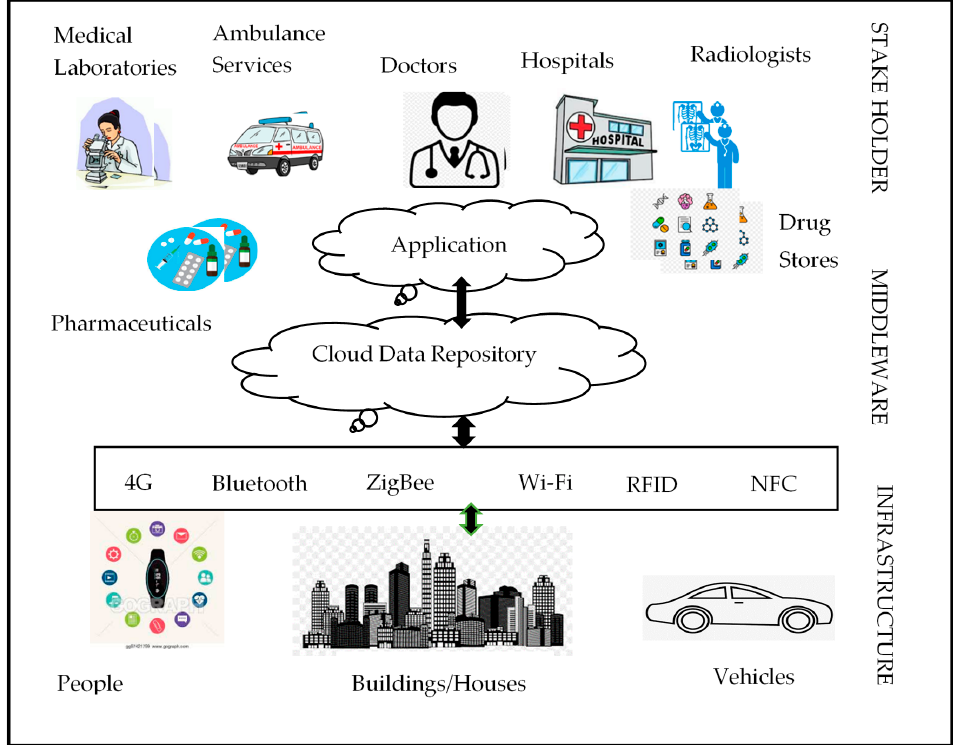
Figure 3. Zone level healthcare system architecture .